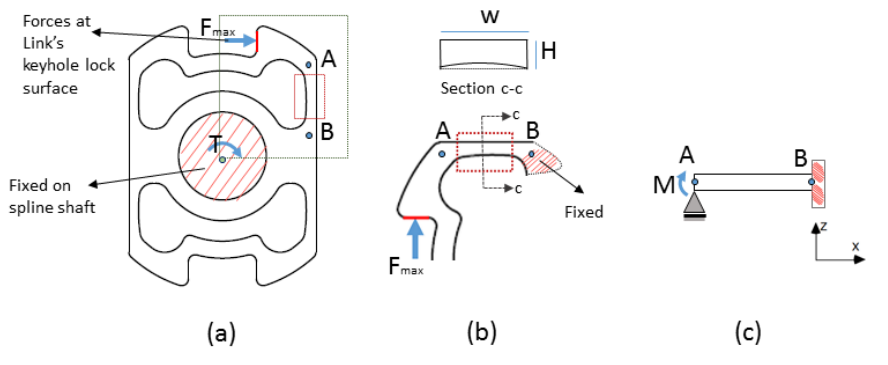
Figure 6. Simplified SCTS analytical structural model; ( a ) SCTS where the square box highlights a single wing; ( b ) close-up view of SCTS’s wing; ( c ) wing represented by cantilever beam.